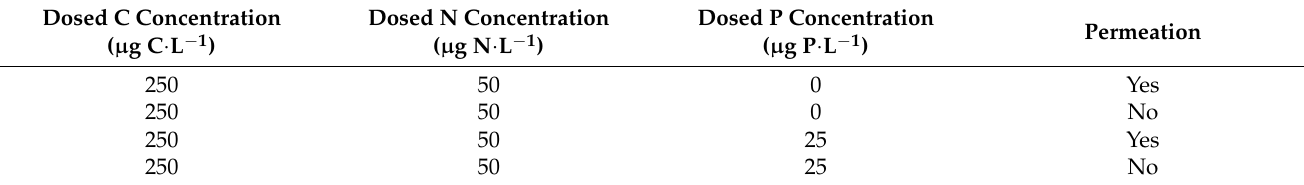
Table 1. Experimental nutrient and operational conditions for the study (experiments were run in triplicate